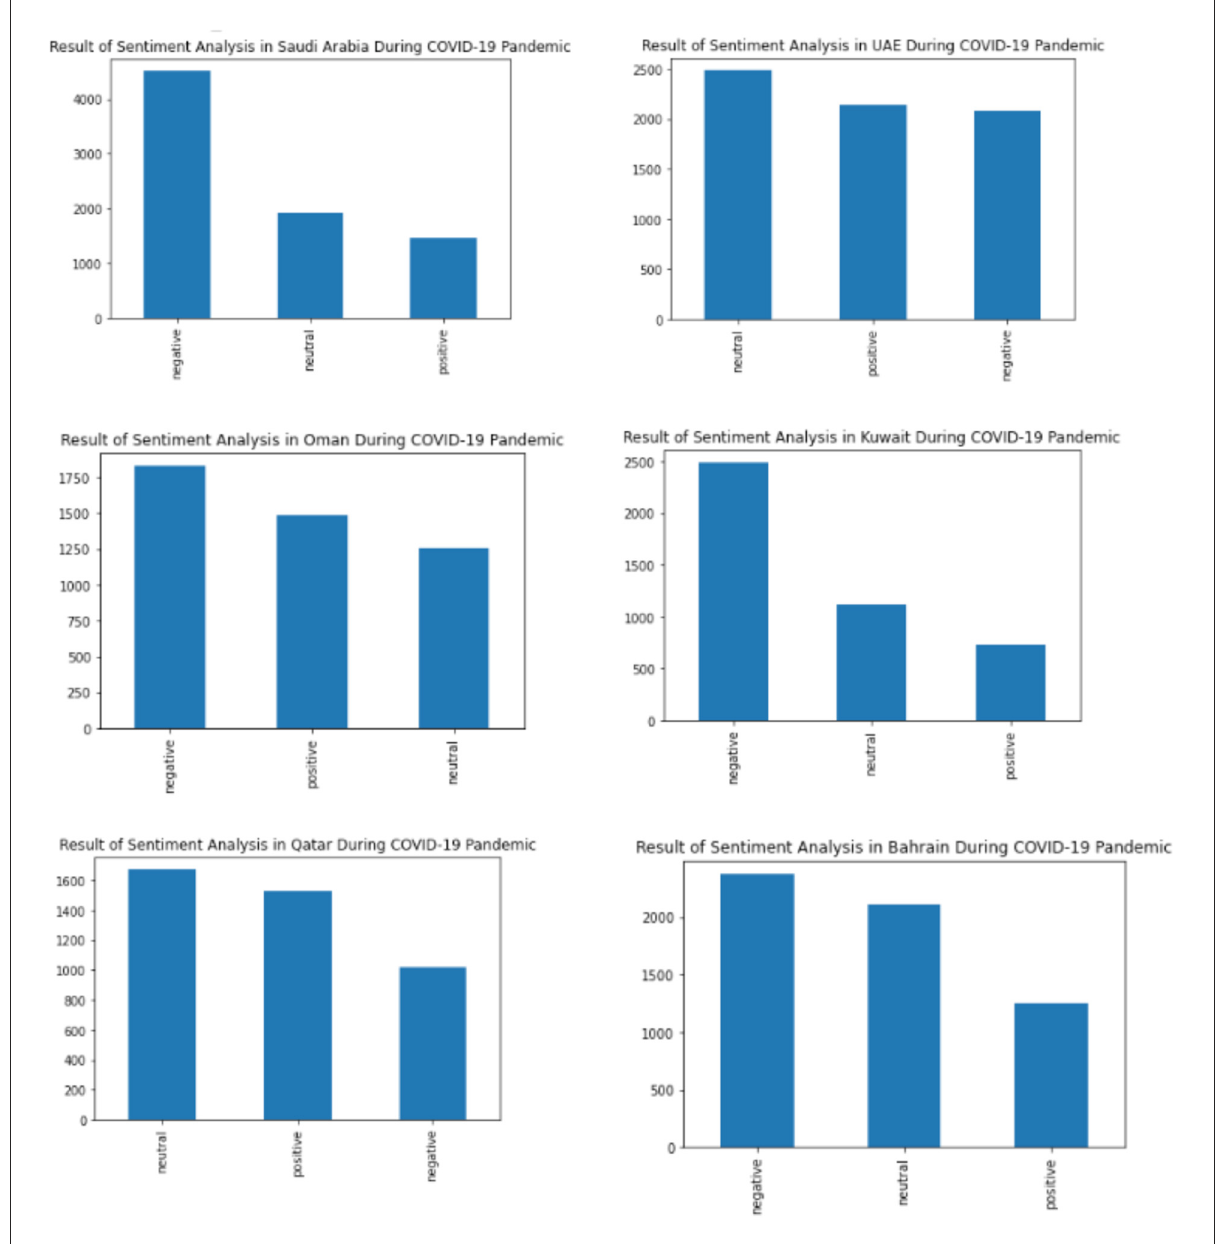
FIGURE9 The results of Sentiment Analysis in Each Gulf Country.